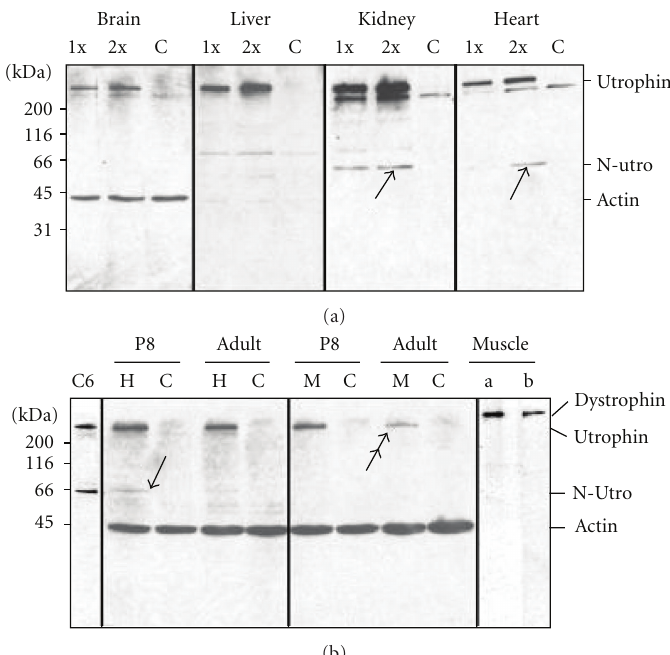
Figure 3: Immunoblots of rat tissues for full-length utrophin and N-utrophin (4–10% SDS-PAGE). (a) Adult tissues with protein loads of ∼ 45 μ g (1x), ∼ 90 μ g (2x), and ∼ 90 μ g for C. All lanes stem from one gel blotted onto nitrocellulose membrane. After staining with Ponceau- S, the membrane was cut for separate immunostaining (1x and 2x together plus lane C separate). Lanes 1x and 2x were incubated with anti-UT11. Anti-UT11 recognises full-length ( ∼ 395 kDa) and N-utrophin ( ∼ 65kDa). C Lanes present competition by preincubation of the serum with recombinant UT11 antigen (10 μ L/mL serum) before loading onto the blot. In addition, actin ( ∼ 44kDa) was visualised in brain tissue by mixing anti-actin antibody with anit-UT11. Finally, the di ff erently incubated membrane lanes were precisely joined together for exposure on X-ray films. Full-length utrophin is seen in all tissues and N-utrophin in kidney and heart. Competition with UT11 antigen removes full-length and N-utrophin. The second lower band underneath the full-length utrophin may represent a degradation product which is, however, only partially removed by antigen competition. (b) The same approach was employed with the gel comprising H, M, and C, except that anti-actin antibody was added to all lanes for loading control and as internal molecular size marker. Protein load was ∼ 90 μ g protein of heart (H) and muscle (M) from young (8 days postnatal) and adult tissues. N-Utrophin can only be seen as a faint band in young heart tissue (arrow). The band of full-length utrophin is greatly reduced in adult muscle (double arrow) and abolished by competition in all samples labeled with C. For comparison, C6 rat glioma cells stained with anti-UT11 displaying full-length and N-utrophin as well as adult muscle stained with anti-DYS12 (a) and NCL-DYS1 (b) derived from di ff erent gels are included. 1 mM ATP, 1 mM DTT, 6 mM MgCl 2 , and the